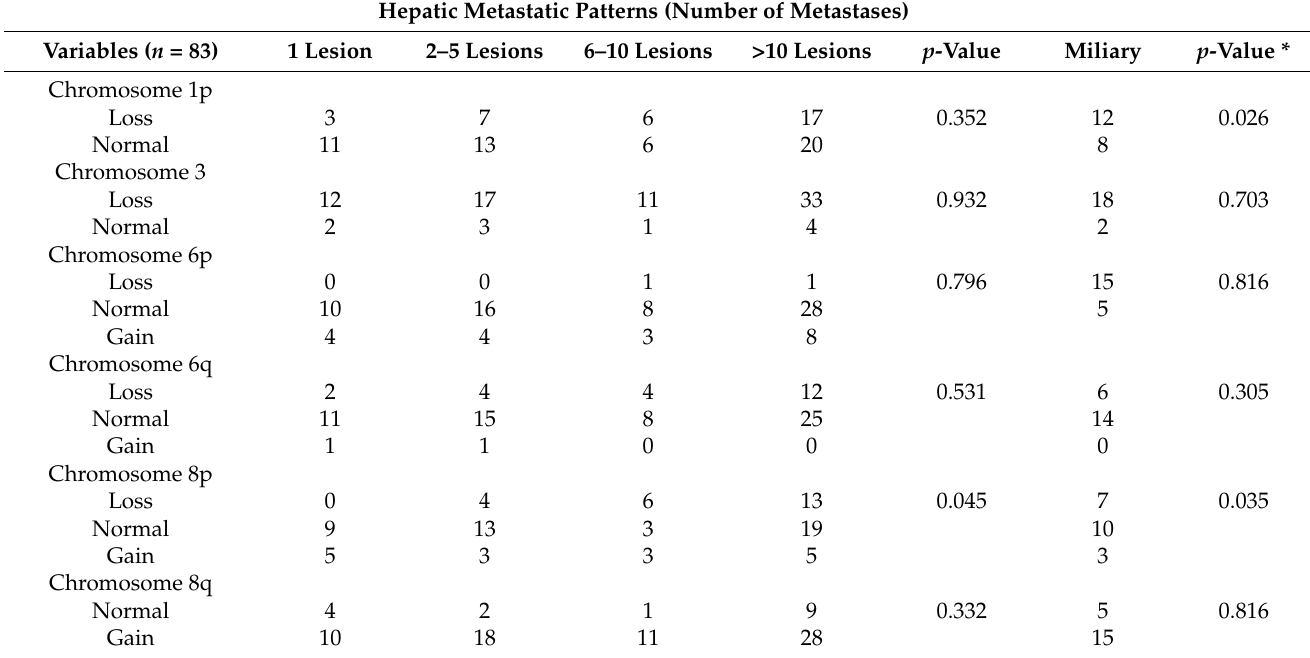
Table 3. Correlation between the number of metastatic lesions and the chromosomal abnormalities. Hepatic Metastatic Patterns (Number of